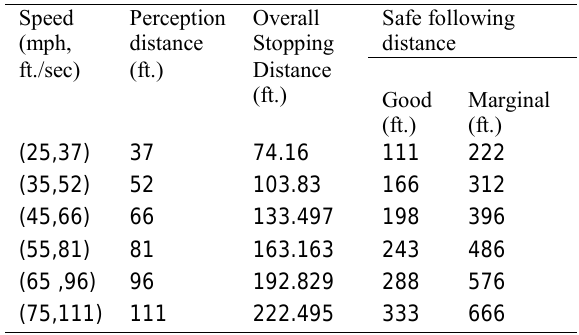
Table 2. Safe Breaking and Following Distance [20]